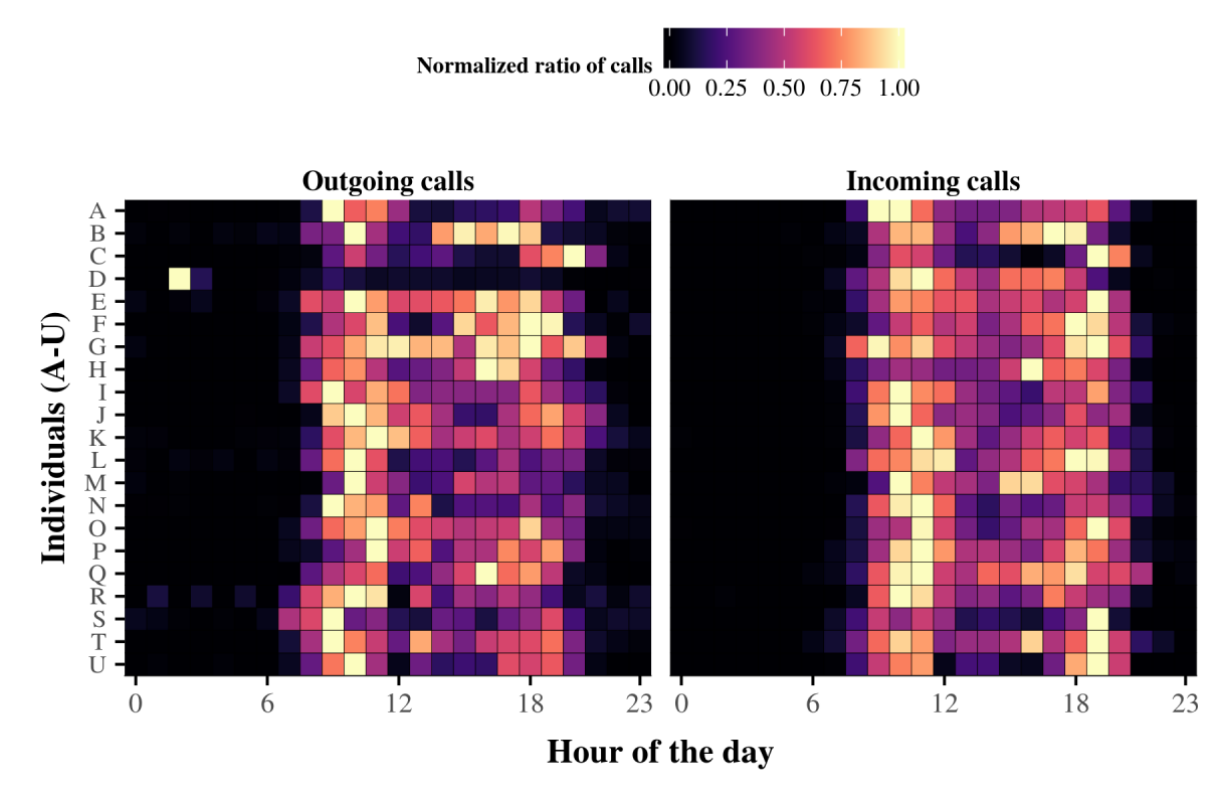
Figure 3. Normalized daily rhythms of outgoing and incoming telephone activity at the individual level. The normalized daily rhythms for each ego are aggregated into a heat map for the outgoing telephone calls (right panel) and for the incoming telephone calls (left panel). The colored squares in each row give the daily rhythm for the telephone calls of one ego with 1-hour resolution (see color scale at the top). Higher fractions of telephone calls correspond to brighter squares. The results show that, in general, most telephone activity occurs during the day rather than at night, except for ego D. Similarities and differences also appear in the way egos place telephone calls versus how they receive telephone calls during the day. Taken together, these observations highlight the potential of telephone activity to reveal the daily rhythms of social activity in older